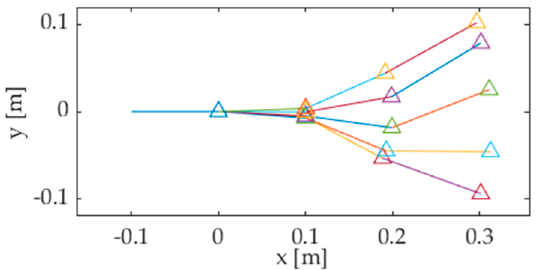
Figure 6. Optimal pose of the linkage corresponding to five tail postures.